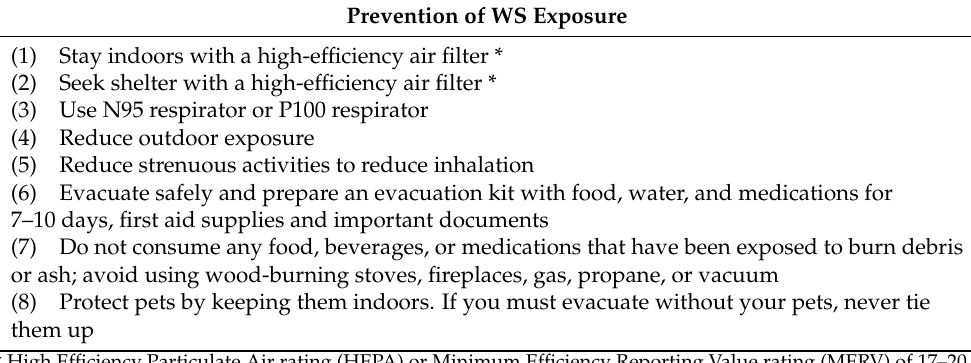
Table 4. Prevention strategies to reduce wildfire smoke exposures for vulnerable